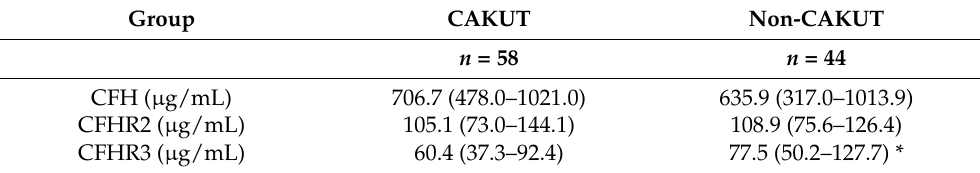
Table 2. Plasma complement factor H and related protein level in children with